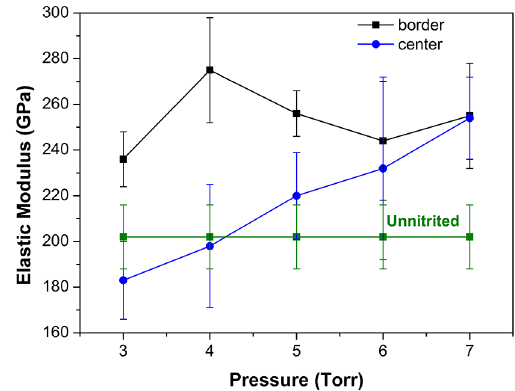
Figure 4. Elasticity values on border and central regions as a function of the nitriding